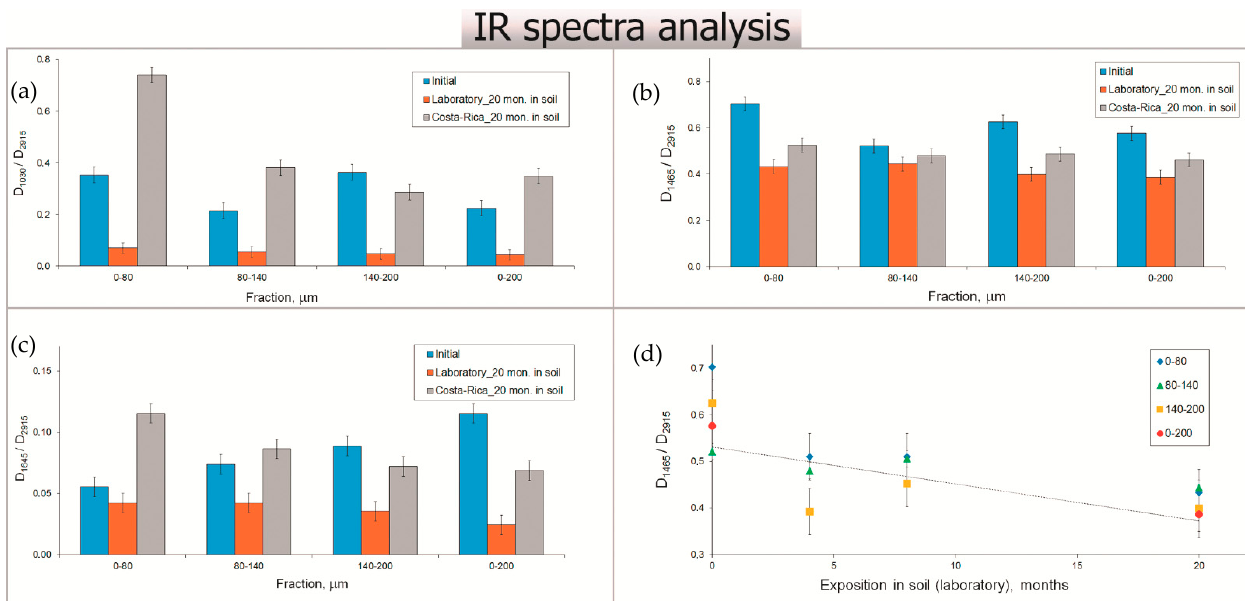
Figure 6. FTIR data analysis. The share of bands height at 1030 ( a ), 1465 ( b ), and 1645 cm − 1 ( c ) to reference band at 2915 cm − 1 . The reduction kinetics of band at 1465 cm − 1 during the biodegradation test ( d ).